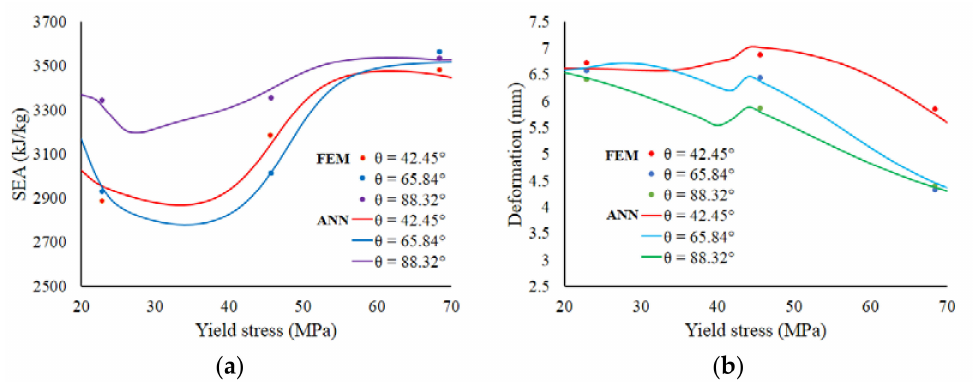
Figure 13. The crushing behavior in terms of: ( a ) SEA; ( b ) deformation, δ , as functions of yield strength at constant ρ = 0.273. Meanwhile, the effects of relative density and lattice angle parameters on internal energy absorption of the lattice structure component are more regular, as shown in Figure 14a,b. These results show the energy capacity of the lattice structure increases with the increase of relative density, lattice angle, and yield strength. The increasing of material volume, which follows the increase of relative density, will increase the energy absorption capacity. The lattice angle, as shown in Figure 15, is also directly proportional to the diameter of lattice trusses. With a larger diameter of trusses, the lattice structure will become stronger to resist the impact loading. Finally, the higher material yield strength implies higher plastic energy capability to absorb the impact loading